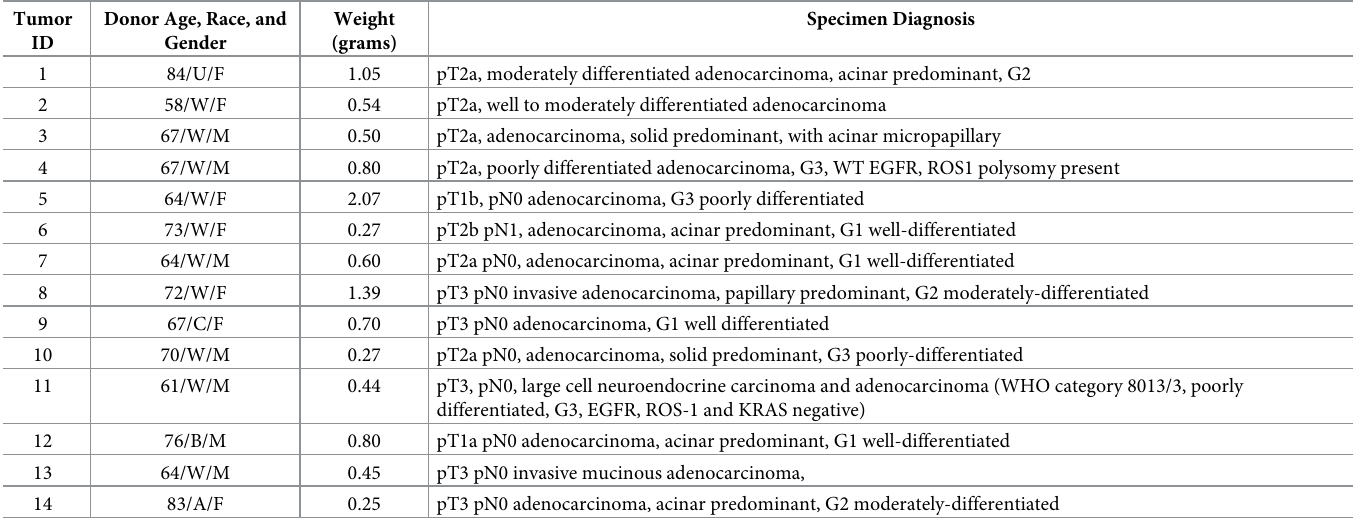
Table 1. Information on tumor tissue donors, sample weights and diagnoses. Tumor Donor Age, Race, and ID